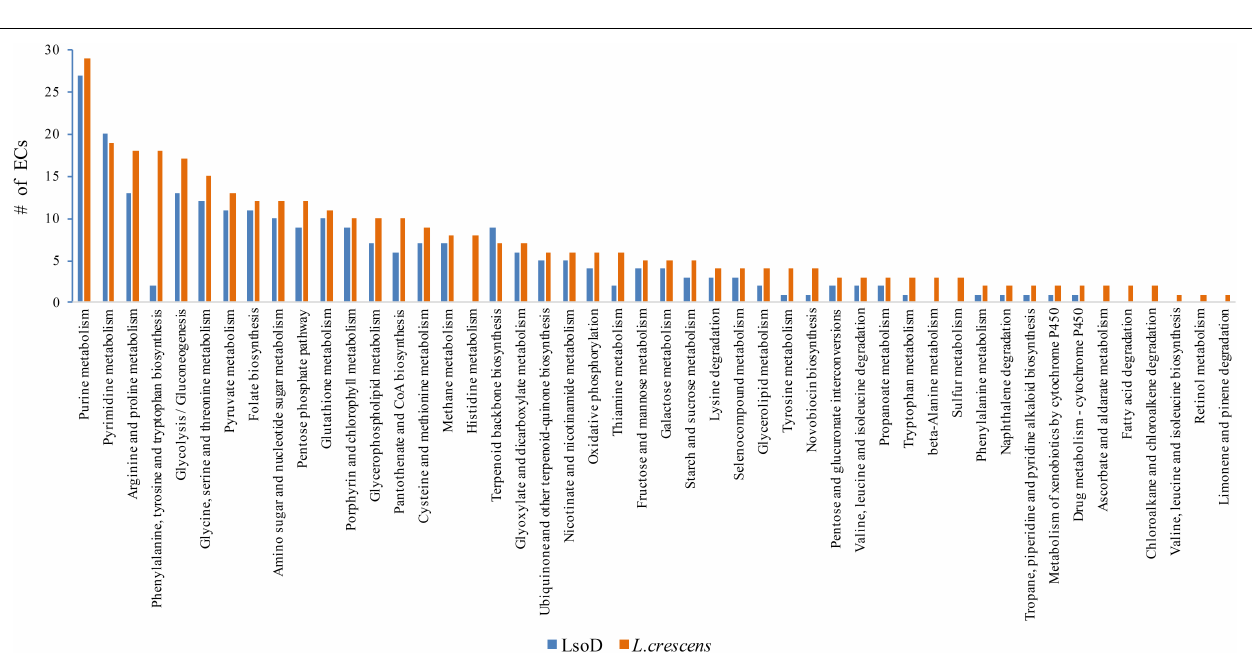
FIGURE 4 | Comparison of clusters of orthologous groups (COGs) assignments determined by the WebMGA server of LsoD and L. crescens are plotted as a percentage of their total respective genomes. The absolute number of genes is indicated above each bar.